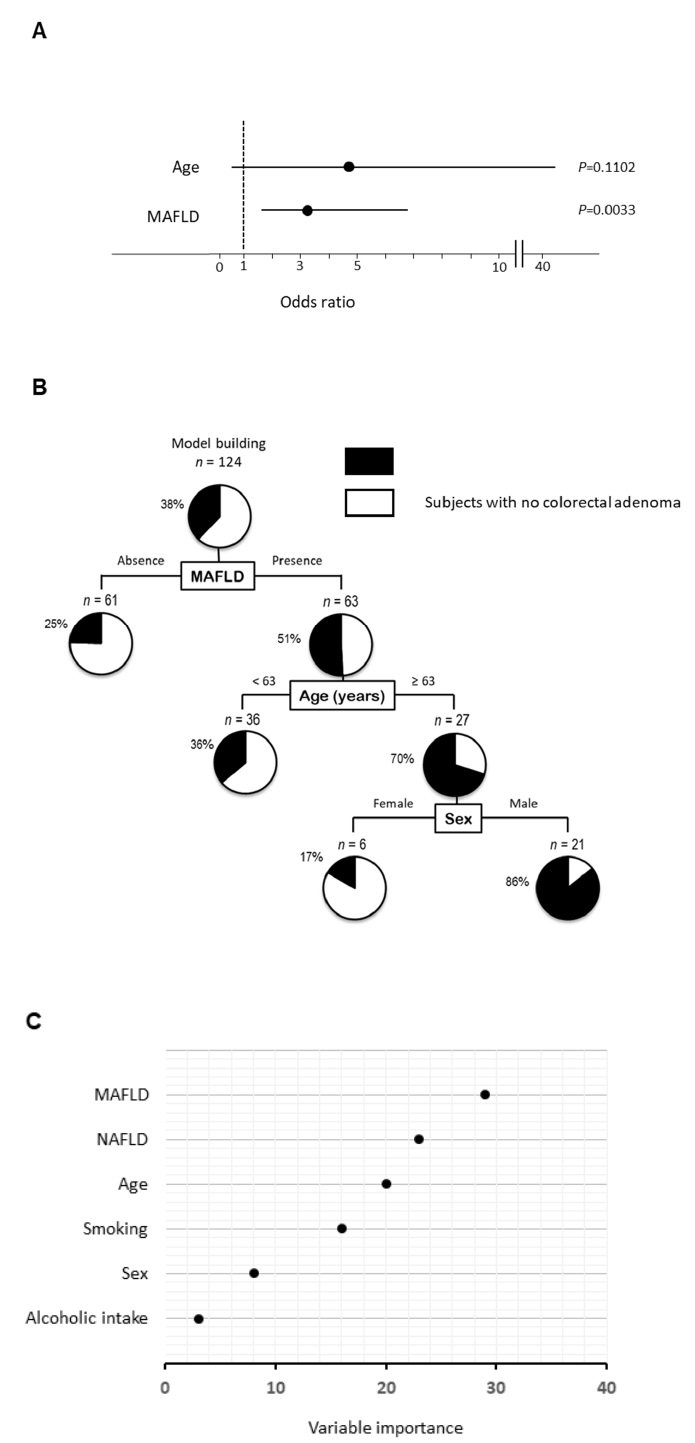
Figure 2. Independent factors and profiles associated with the presence of colorectal adenoma. ( A ) Independent factors for the presence of colorectal adenoma analyzed by logistic regression analysis, ( B ) profiles for the presence of colorectal adenoma analyzed by decision-tree analysis. The pie graphs indicate the proportion of patients with colorectal adenoma (black) and patients with no colorectal adenoma (white), ( C ) distinguishing factors for the presence of colorectal adenoma analyzed by random forest analysis. The relative contributions of each variable to the presence of colorectal adenoma is expressed by variable